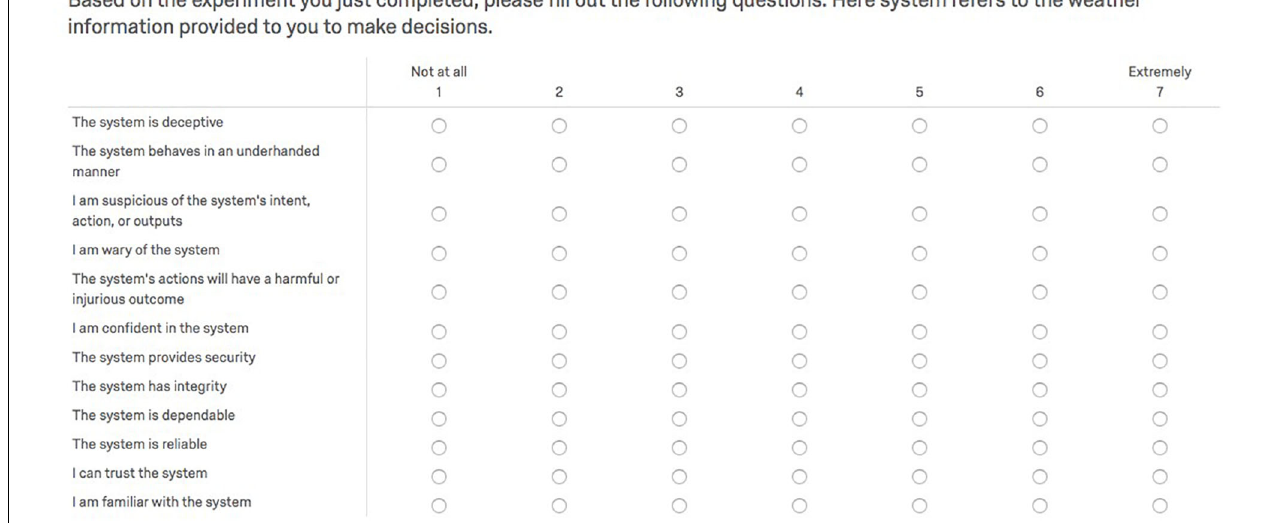
function and normally distributed errors, because the scores were continuous. To assess learning, we analyzed proportion correct using a GEE with a probit link and binomial distribution because the percent correct is a binary variable. To evaluate learning transfer, we relied on both the parametric Pearson for both performance (percent correct) and BS. The trust in automation scores was evaluated via one-way ANOVA, followed by post hoc comparisons and correlations.